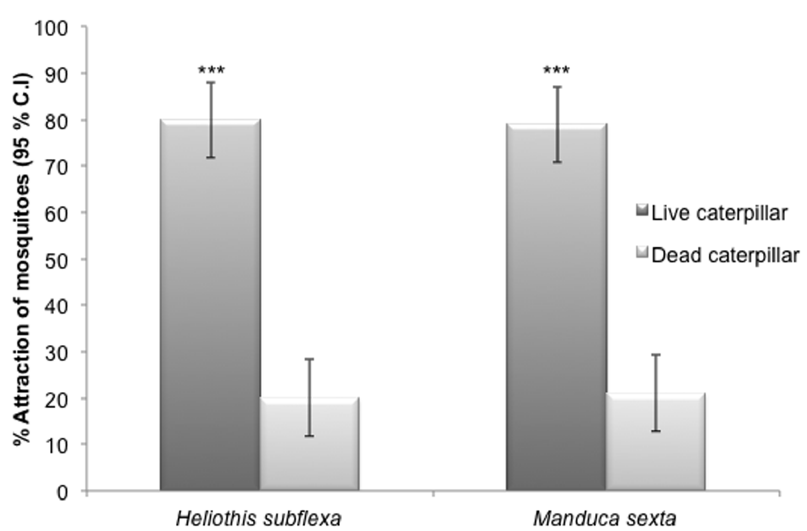
Figure 4. Y-tube olfactometer assays of An.stephensi females that were given a choice between live vs. dead caterpillars of two moth species. The figure shows the percentage of female An. stephensi ( 6 95% binomial confidence intervals (C.I.) that were attracted to live fourth instar larvae of Heliothis subflexa or Manduca sexta (black bars) versus dead caterpillars killed by freezing and then thawed back to room temperature (light bars). Asterisks denote significantly different levels of attraction (Chi-square 2 6 2 test of independence; *P , 0.05; **P , 0.01; ***P , 0.001; N=90).